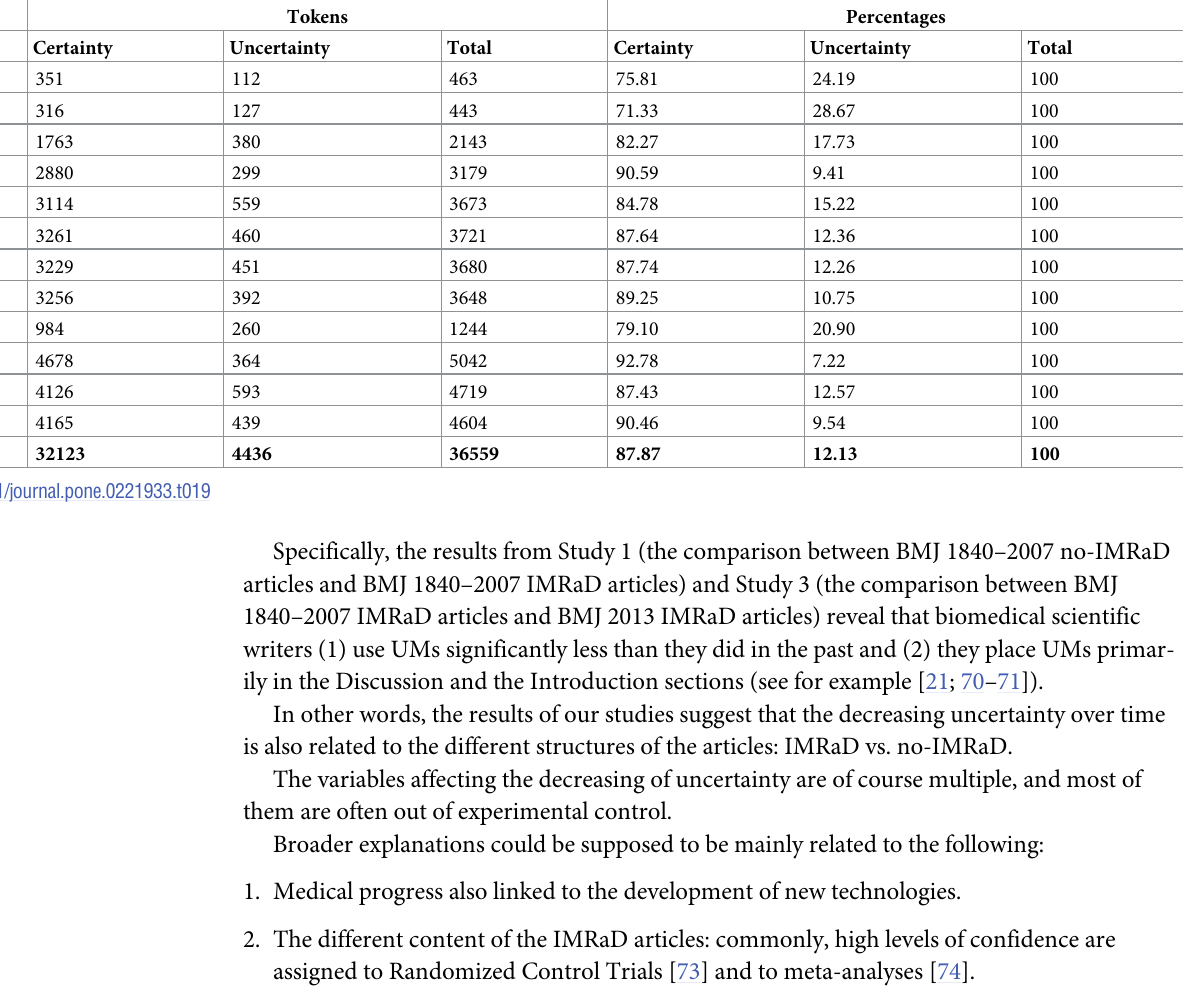
Table 19. Percentages of certainty and uncertainty in each article and in the whole corpus of Discover 2013.